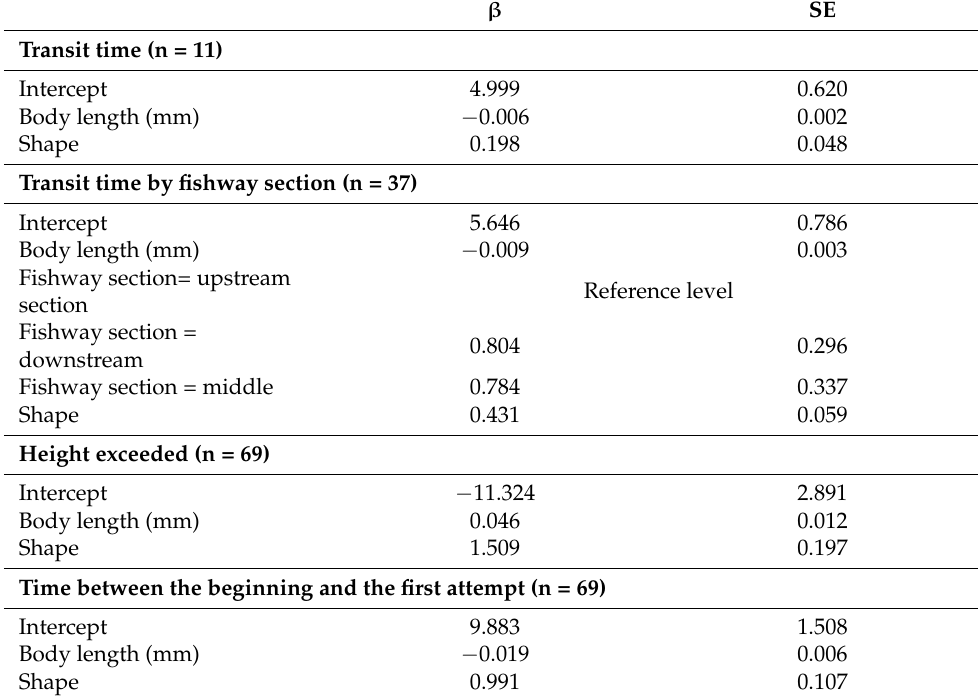
Table 5. Summary of the parametric model for the prediction of the response variables (log-logistic was the best-fitted distribution). The β terms are the regression coefficients and SE is the Standard Error (see Figure 5 for the graphical